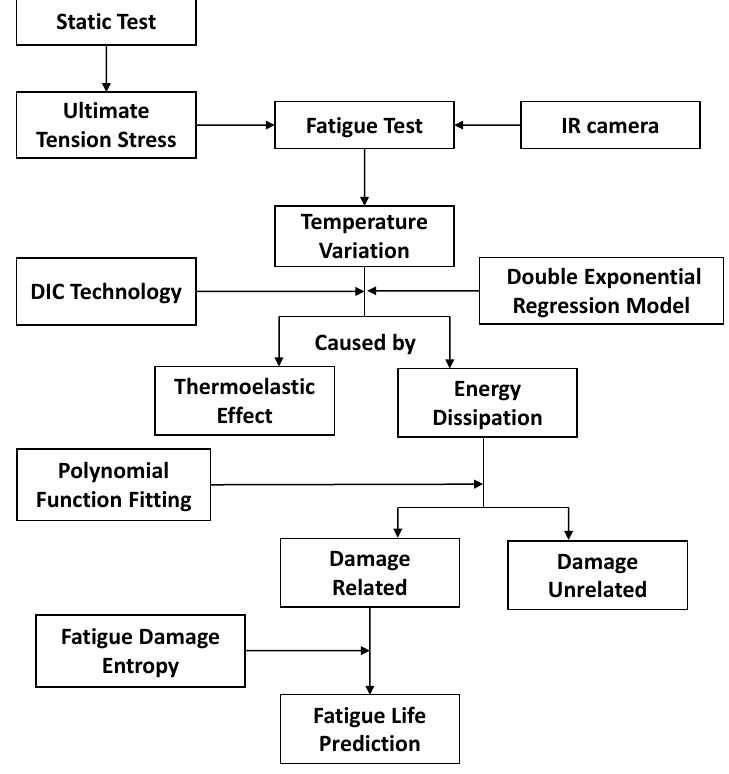
Figure 4. Scheme of the experimental and data-processing